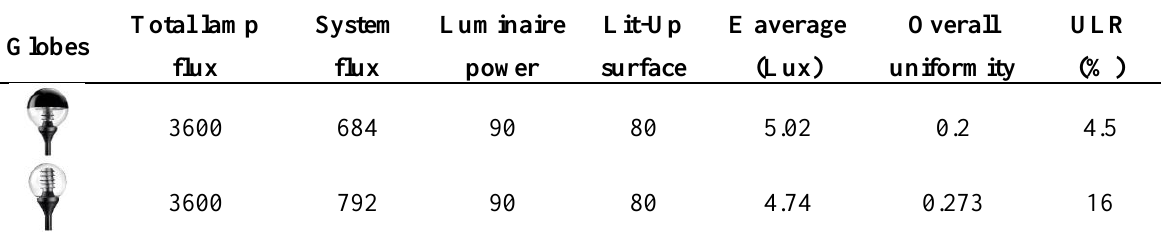
Table 8. ULR regarding the street lamp